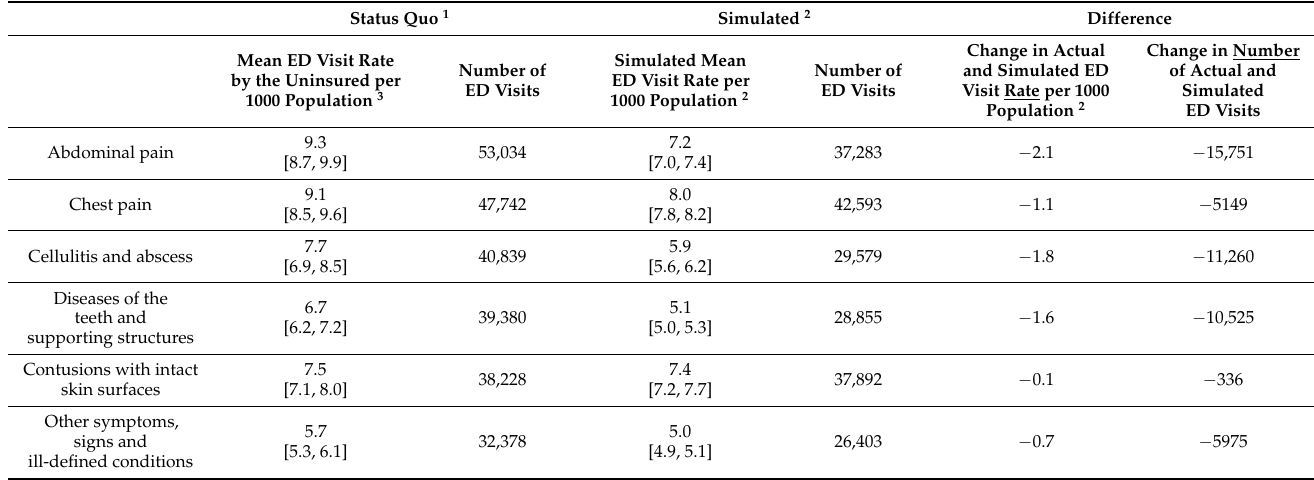
Table 4. Simulated Changes in ED Visits in Response to Changes in the LTU for Quintile